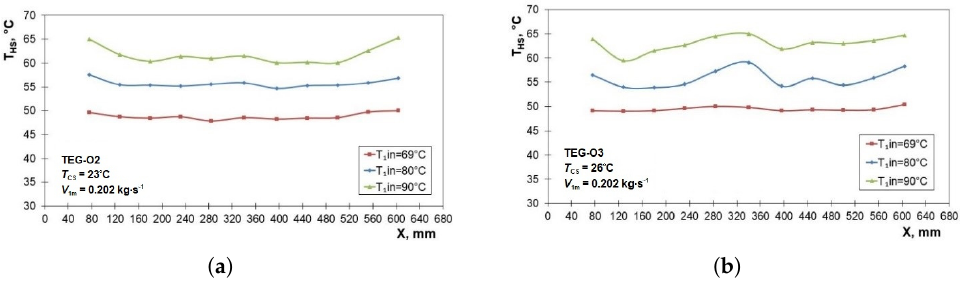
Figure 12. Temperature difference distributions along the HSHE with varying supply temperatures, for the two selected circulations: ( a ) TEG-O2; ( b ) TEG-O3.